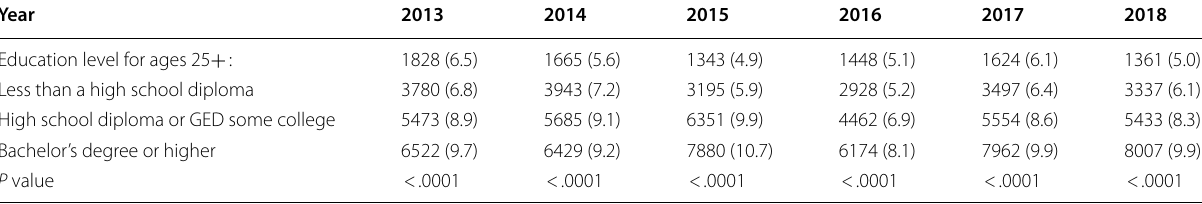
*Estimates are considered unreliable. Data preceded by an asterisk have a relative standard error (RSE) greater than 30% and less than or equal to 50% and should be used with caution. Data not shown have an RSE greater than 50% (according to the